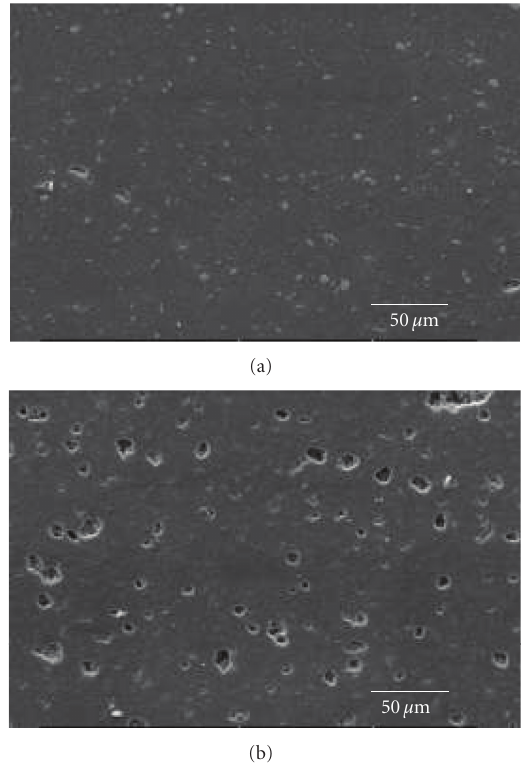
Figure 7: Comparison of microstructure of LZSA laminates (10 layers): 800 ◦ C (a) and 900 ◦ C (b).